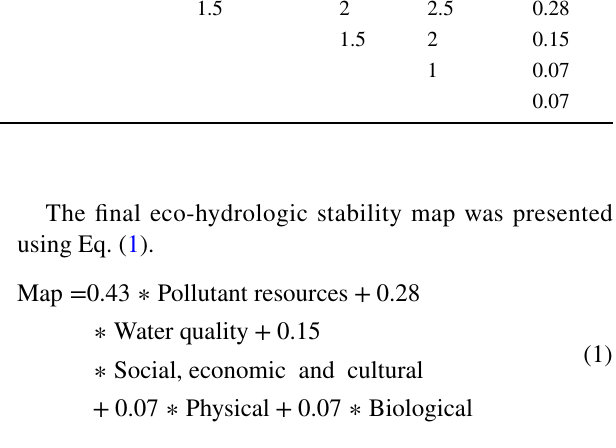
Table 4 Weights of different factors obtained based on the goal